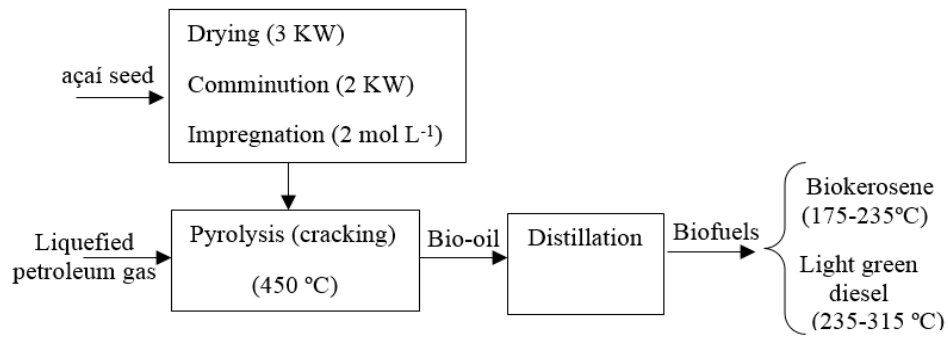
Figure 3. Scheme of conversion of açaí seed ( Euterpe oleracea) into